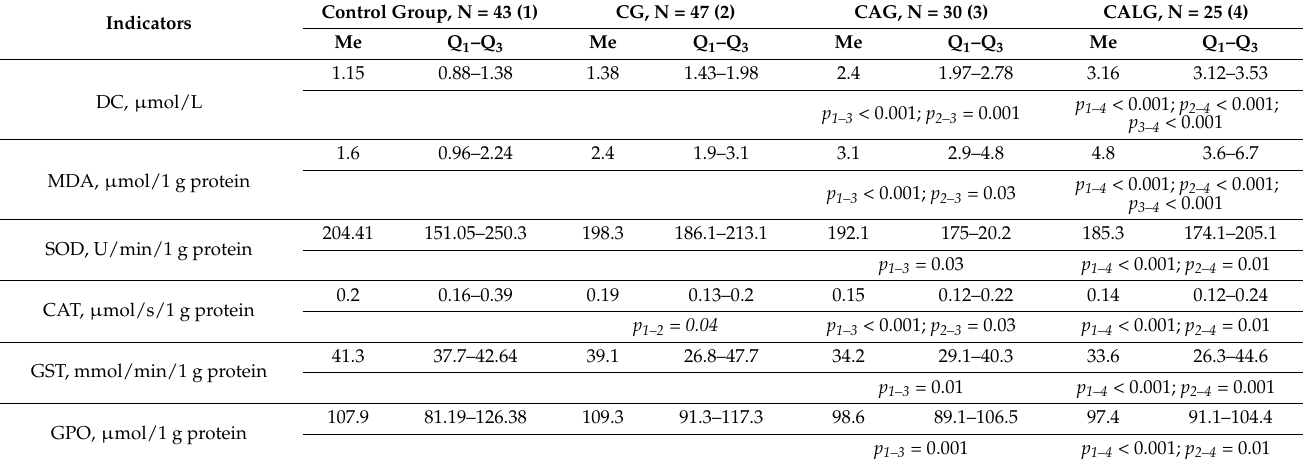
Table 5. Characteristics of indicators of the LPO–AOD system in various types of chronic gastritis with a serum response against H. pylori in the form of “low concentrations of IgG,